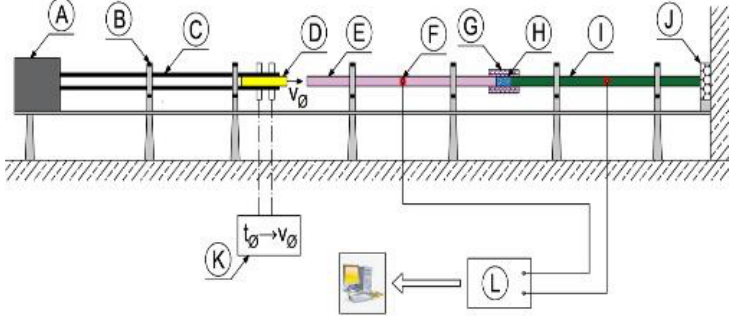
Figure 1. General scheme of the SHPB stand at Department of Military Engineering and Infrastructure, MUT (reprinted from Ref. [70]).